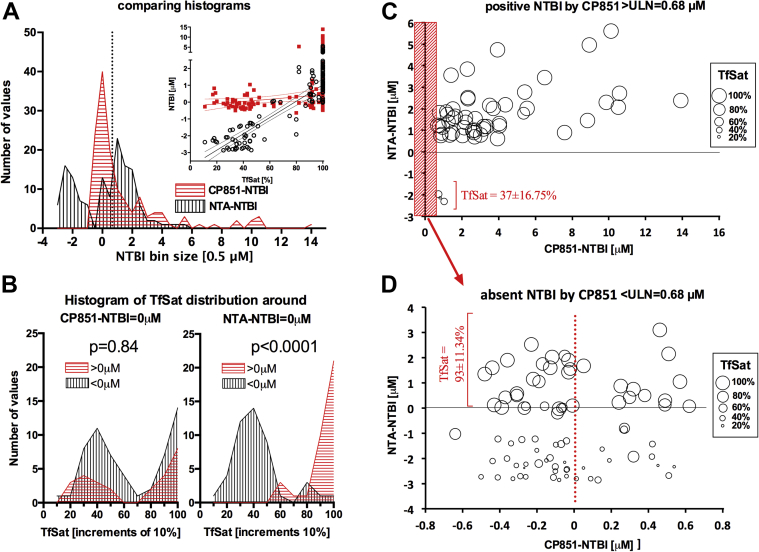
Distribution of CP851-NTBI, NTA-NTBI, and transferrin saturation values with analysis of false-positive and false-negative NTA-NTBI values. (A) Comparing frequency distribution histograms of CP851-NTBI (red) and NTA-NTBI (black) in 135 pairs; frequency (number of values) of NTBI per interval of 0.5 μM (bin size) is shown. Inset shows the relationship between NTBI level and urea-gel TfSat for both methods: CP851-NTBI (red) and NTA-NTBI (black); best-fit linear regression slope differences (P < 0.0001) with 100% TfSat points excluded from regression. (B) Plots of Tf saturation on x-axis (in 10% increments, bin center) against frequency of TfSat observations (y-axis) for NTBI values < or > 0 μM. The left panel shows bead method and right panel NTA method. The TfSat distributions for NTBI values > 0 μM are significantly different from those under 0 μM by the NTA method only (Mann-Whitney test); at low TfSat negative NTBI values are significantly more likely by NTA method and at high TfSat positive NTBI values are more likely by NTA method. These differences are not apparent by the beads method. (C) The plot of NTA-NTBI values vs. true-positive bead-NTBI values (above ULN = 0.68 μM—dashed line in Figure 1A), the size of the point reflects TfSat. Data in the red-shaded box (below ULN) are shown in panel D. (D) The plot of NTA-NTBI vs. true-negative bead-NTBI (red-shaded box in panel C corresponds to the data to the left of the dashed line in Figure 1A) with point size reflecting TfSat. Mean TfSat for NTA values >0 μM was 93%, 19/36 were 100%, range 62–100%, median, 25th and 75th percentile: 100, 91, 100%. Mean TfSat for NTA values <0 μM was 41.5%, 1/46 was 100%, range 11–100%, median, 25th and 75th percentile: 39.5, 31.5, 46%. NTBI, nontransferrin-bound iron; NTA, nitrilotriacetate; TfSat, transferrin saturation. (For interpretation of the references to color in this figure legend, the reader is referred to the Web version of this article.)